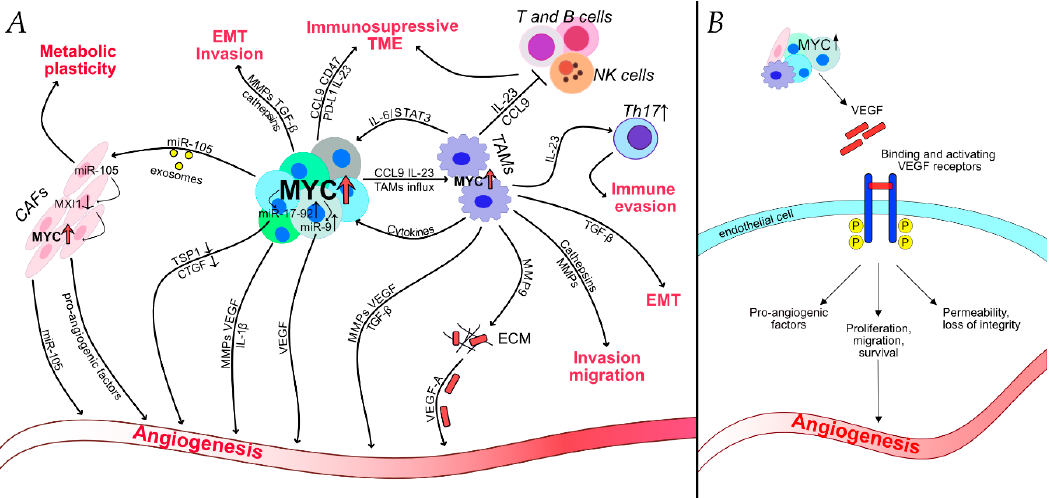
Figure 2. MYC and the tumor microenvironment. ( A ) MYC is an essential instructor of the tumor microenvironment [11,18,24,30,103,104]. MYC promotes cancer aggressiveness not only by influencing cancer cells’ biology but also by recruiting stromal and infiltrating inflammatory cells. The goal of this MYC-regulated crosstalk between host and cancer is to create a microenvironment that is favorable for cancer cells—facilitating growth, invasion, migration, and helping to evade the anti-tumor immune responses. ( B ) MYC controls the “angiogenic switch” [54,99]. MYC is involved in a lot of di ff erent direct and indirect mechanisms for promoting angiogenesis. MYC induces secretion of VEGF both in cancer cells and tumor-associated cells. VEGF proves to be the main factor in promoting MYC-dependent